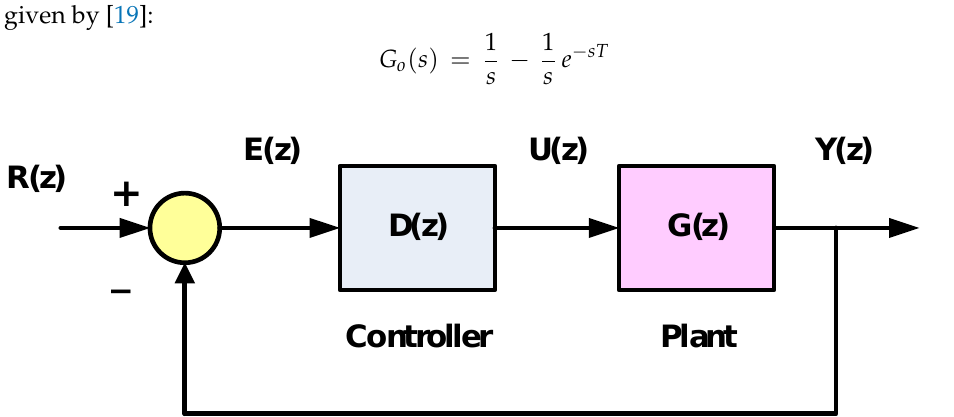
Figure 2. Block diagram of a feedback control system with a digital controller.